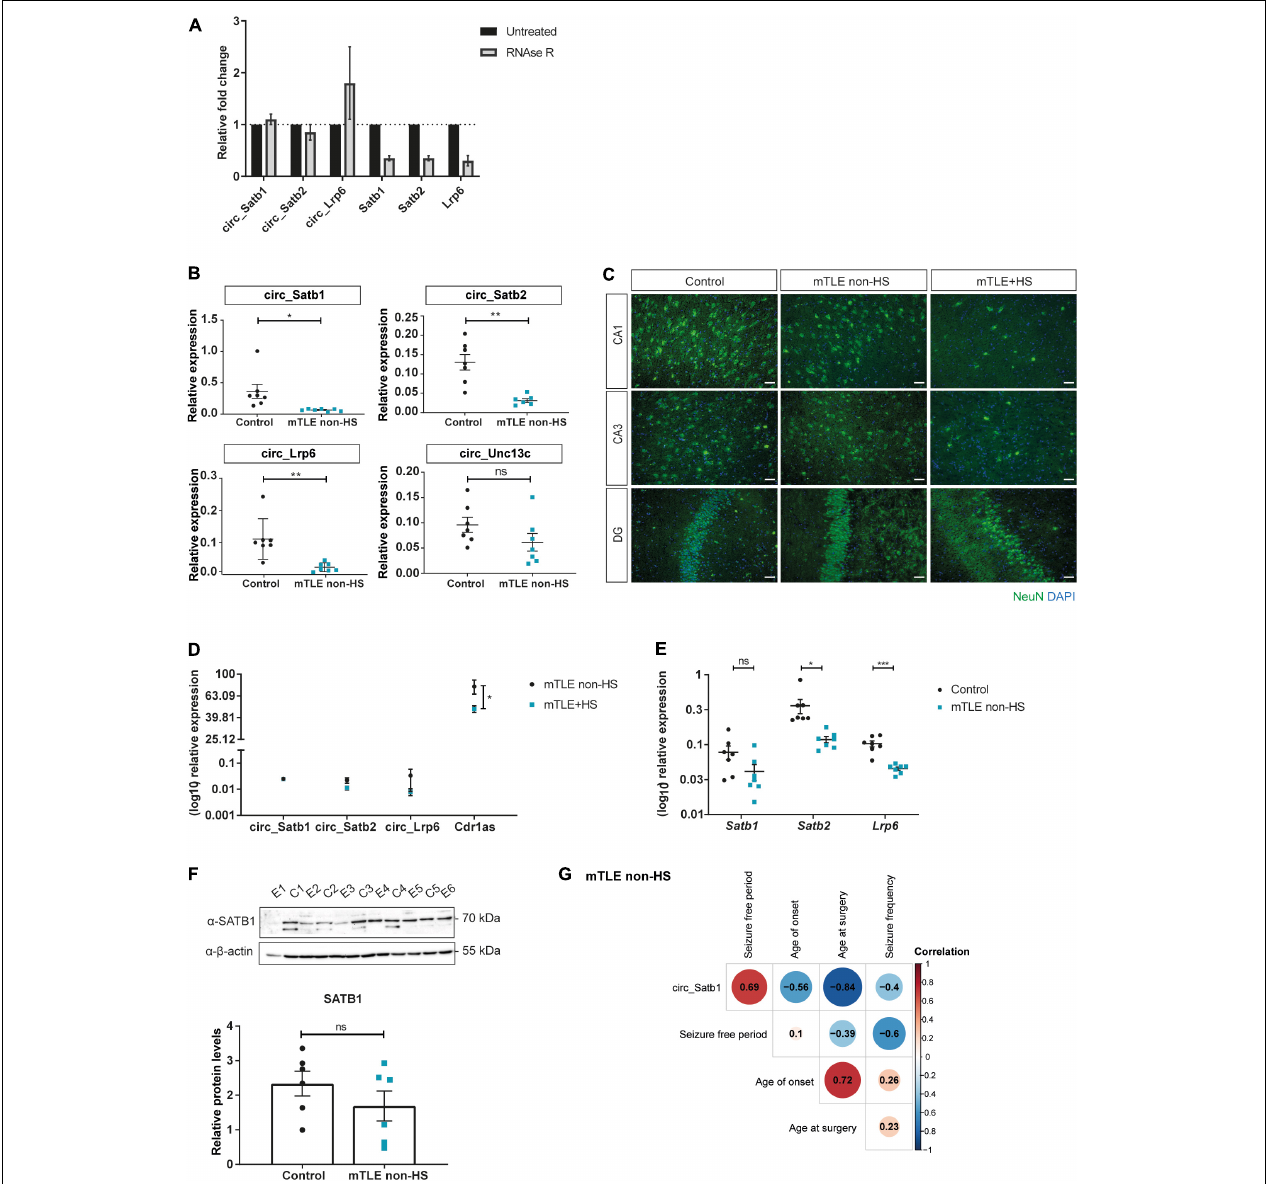
FIGURE 2 | CircRNA deregulation in mTLE patients. (A) Quantification of circular and linear RNA products amplified by RT-qPCR following treatment with RNase R. Values are expressed as fold change means ± SD and are normalized to the untreated condition. N = 2 independent experiments. (B) RT-qPCR analysis of the expression pattern of selected circRNAs in autopsy controls and mTLE non-HS patients (circ_Satb1, * p = 0.0364; circ_Satb2, ** p = 0.0036; circ_Lrp6, ** p = 0.0096; circ_Unc13c, ns). Each dot represents one individual and shows circRNA expression relative to RNA-polymerase II ( RPII) and TATA-Box Binding Protein ( TBP ) transcripts. Values are expressed as means ± SEM. Unpaired two-tailed t -test with Welch correction; n = 7 individuals per group. (C) Characterization of mTLE (non-HS and +HS) and control tissue. Neuronal nuclei (NeuN) staining was performed to characterize distinct mTLE subtypes, with (+HS) or without (non-HS) hippocampal sclerosis, in comparison to autopsy control. NeuN staining is represented in the green channel (488) and 4,6-diamidino-2-phenylindole (DAPI) in the blue channel (405). Scale bar: 50 µ m (mTLE, Mesial Temporal lobe epilepsy; HS, hippocampal sclerosis; CA1/3, Cornu Ammonis area 1/3; DG, dentate gyrus). (D) RT-qPCR analysis of the expression pattern of selected circRNAs in mTLE patients with (+HS) and without (non-HS) HS (circ_Satb1, circ_Satb2, and circ_Lrp6, ns; Cdr1as, * p = 0.0387). Dot plots represent circRNA expression relative to RPII and TBP. Values are expressed as means ± SEM and were log 10 transformed to allow for proper visualization and further statistical analysis, considering the spread of the data. Multiple unpaired t -tests; n = 4–5 individuals per group. (E) RT-qPCR analysis of the expression pattern of circRNA linear counterparts in autopsy controls and mTLE non-HS patients ( Satb1 , ns; Satb2 , * p = 0.0290; Lrp6 , *** p = 0.0003). Each dot represents one individual and shows mRNA expression relative to RPII and TBP. Values are expressed as means ± SEM and were log 10 transformed to allow for proper visualization and further statistical analysis, considering the spread of the data. Unpaired two-tailed t -test with Welch correction; n = 7 individuals per group. (F) SATB1 protein levels in autopsy controls and mTLE non-HS patients, normalized to β -actin. The upper panel shows SATB1/ β -actin detection following SDS-PAGE and Western blot. In the lower panel, bar plots represent mean ± SEM and each dot a specific individual, p ≥ 0.05: ns. Unpaired two-tailed Mann-Whitney test; n = 6 individuals per group (E, epilepsy; C, control). (G) Correlation matrix heatmap of circ_Satb1 expression and clinical information of mTLE non-HS patients. Pearson correlation values are represented in each cell. N = 7 individuals per group.